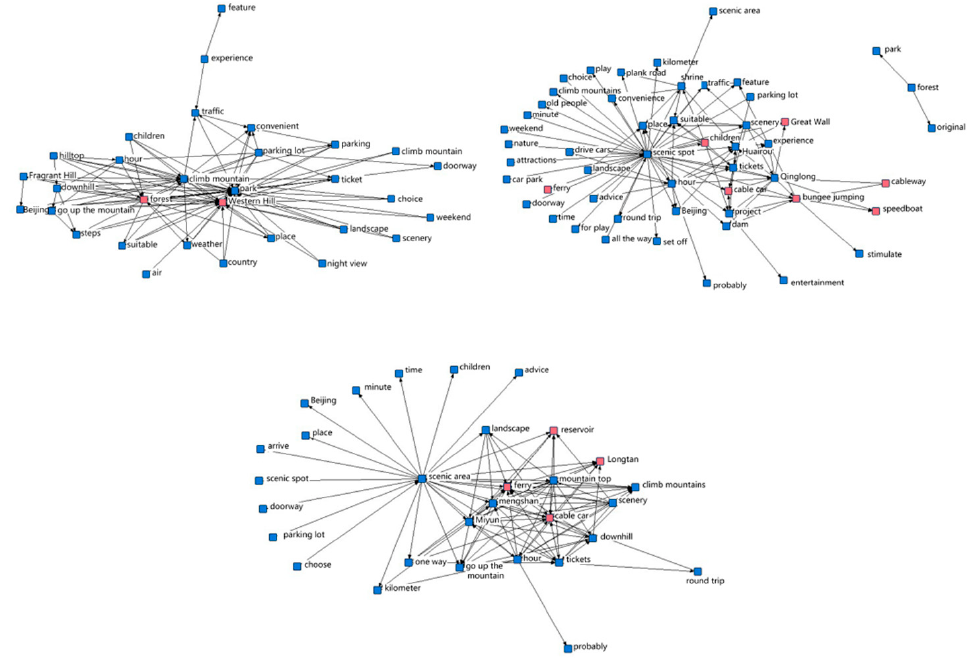
Figure 17. The semantic web of mountain landscapes in various administrative regions (From left to right: Changping District, Fangshan District, and Fengtai District).